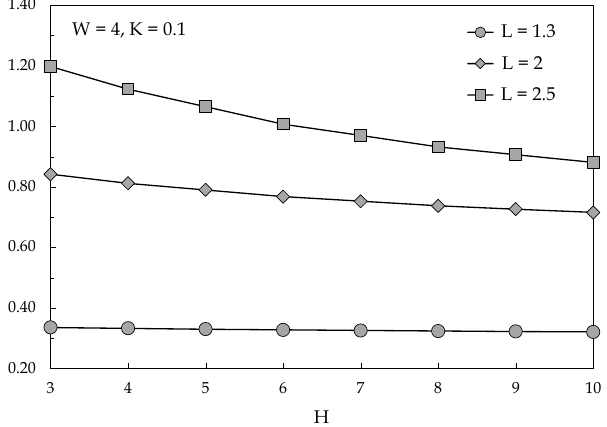
Figure 8. Distributions of the dimensionless thermal resistance ρ pp versus H using L as parameter.